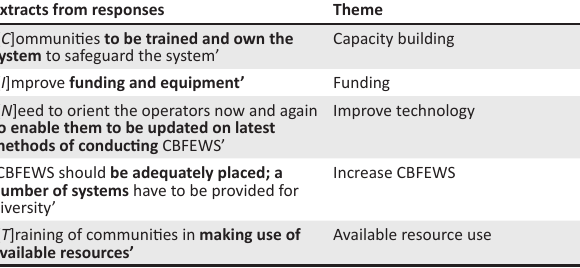
TABLE 4: Proposed improvements of the current system practices.